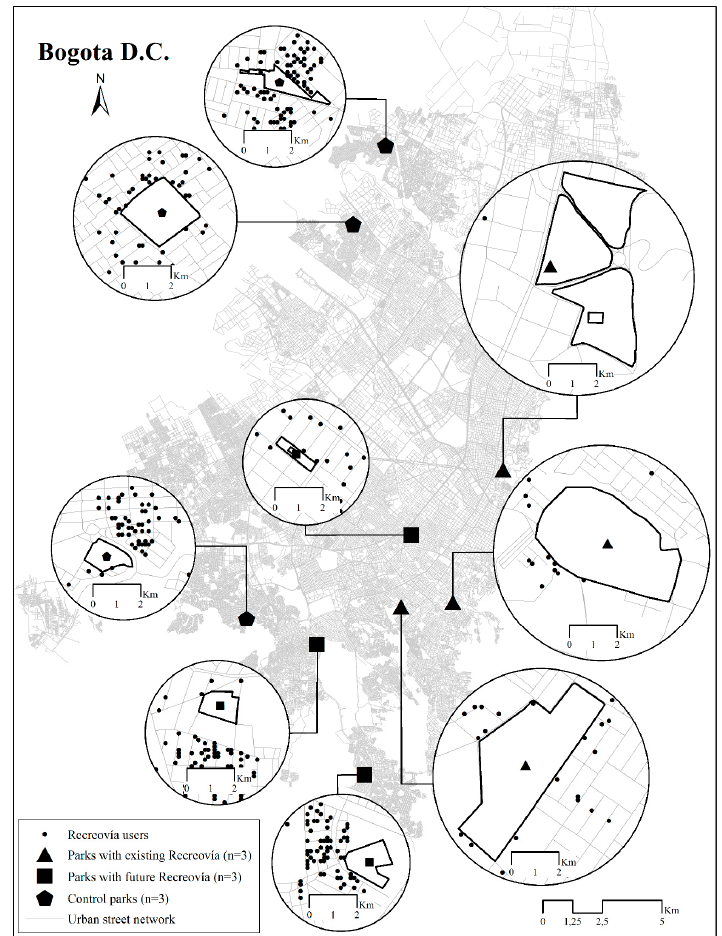
Figure 2. Parks of Bogotá, by presence of Recreovía Program ( n = 9). The black dots represent households of the participants.